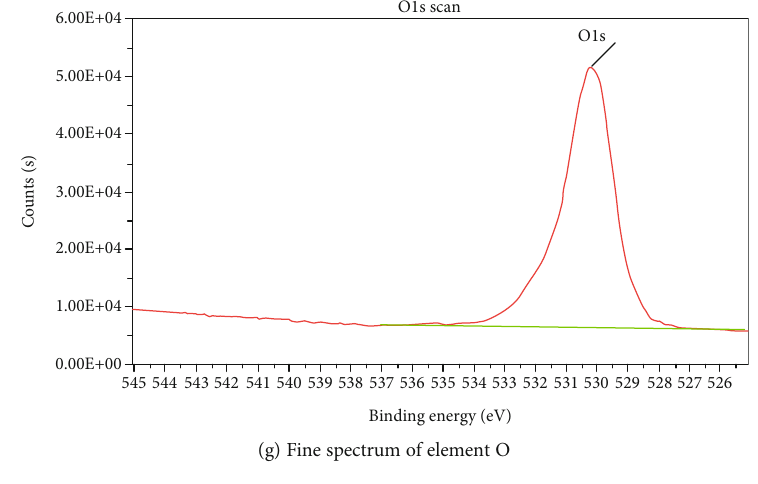
Figure 6: X-ray photoelectron spectroscopy spectrum.